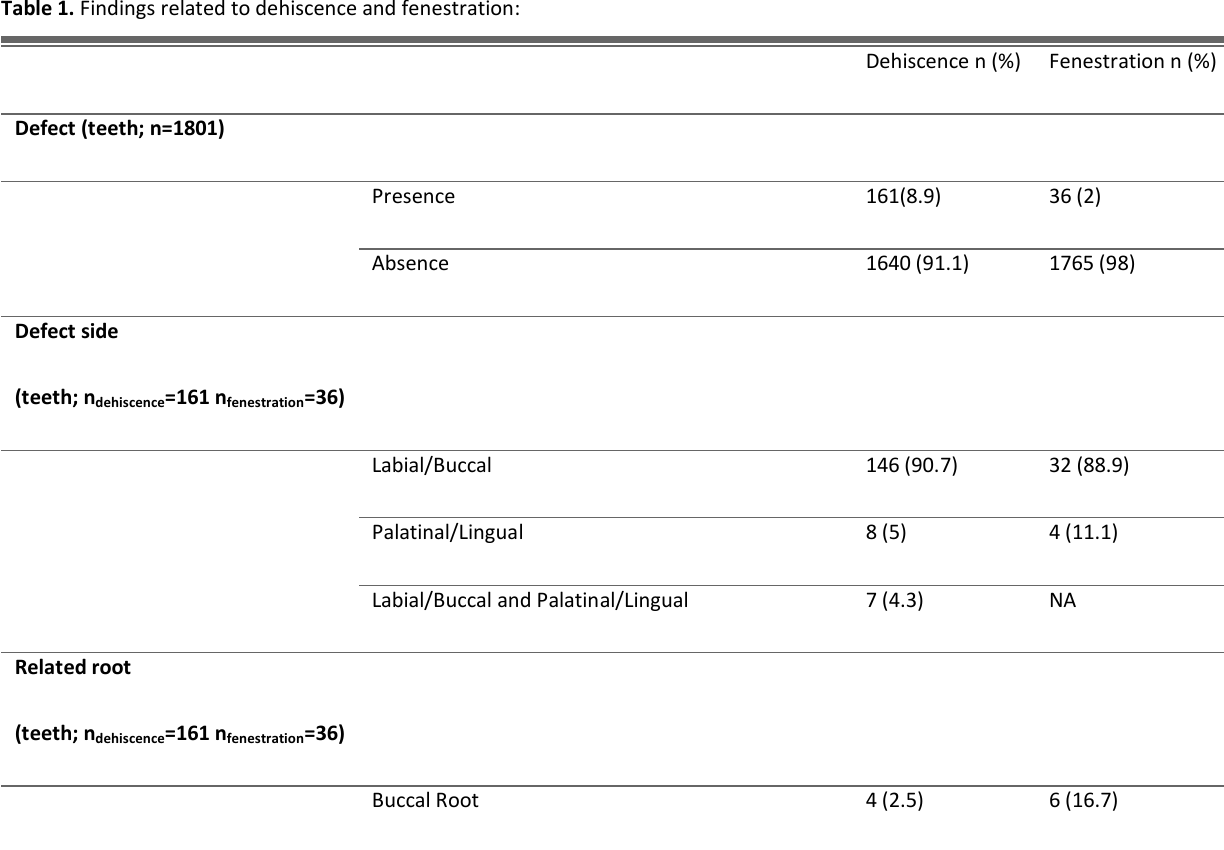
Table 1. Findings related to dehiscence and